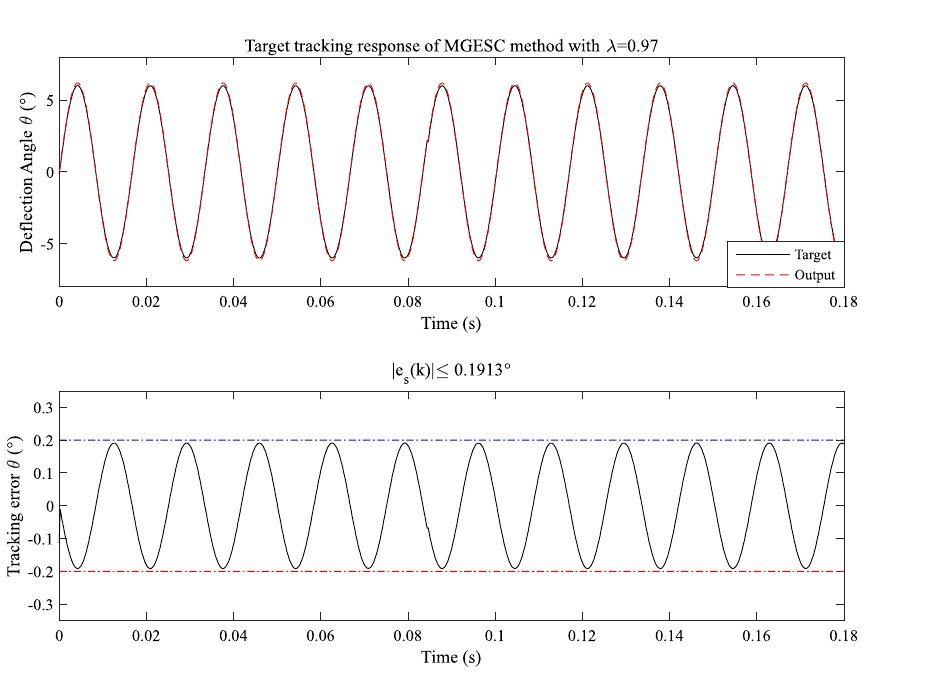
Figure 14. Tracking performance of the MGESC with fixed λ =